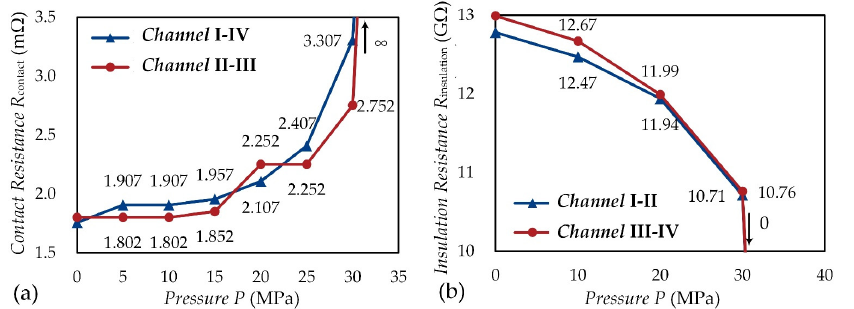
Figure 19. The electrical performance curves of the prototype in a hydrostatic pressure environment: ( a ) contact resistance and ( b ) insulation resistance.